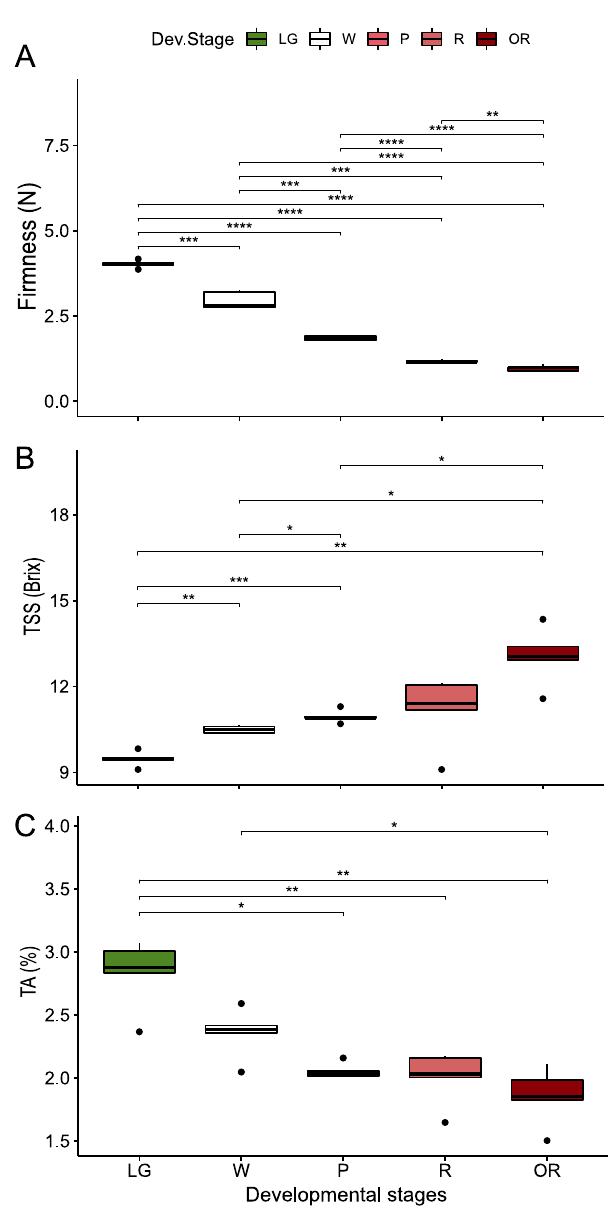
Figure 3. Quality parameters during raspberry ( Rubus idaeus ‘Heritage’) fruit development. Firmness (N) ( A ) was determined in whole fruit, total soluble solids content (TSS, °Brix) ( B ) and titratable acidity (TA, %) ( C ) were determined in drupelets. The fruit was harvested and sorted by size and color as follows: large green (LG), white (W), pink (P), red (R) and overripe (OR) fruit. Data represent the means ± S.D. from five sample units (each containing ten fruits) by the development stage. Asterisks indicate significant differences between all developmental stages, p ≤ 0.05 (*), p ≤ 0.01 (**), p ≤ 0.001 (***) and p ≤ 0.0001 (****). Boxplots show each group’s distribution (developmental stages), and the black line (central value in the box) signs the median value. Points out of the boxplots show outlier